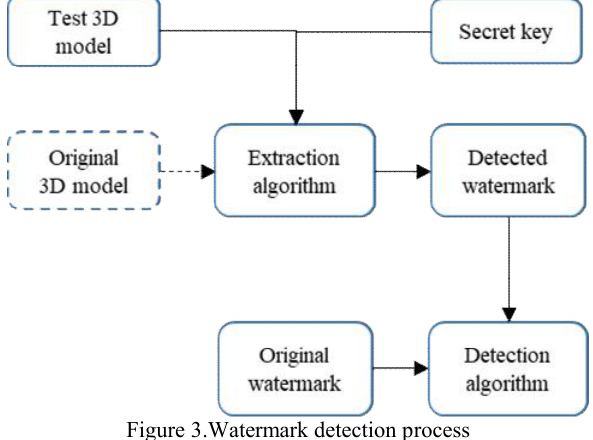
Figure 3.Watermark detection process